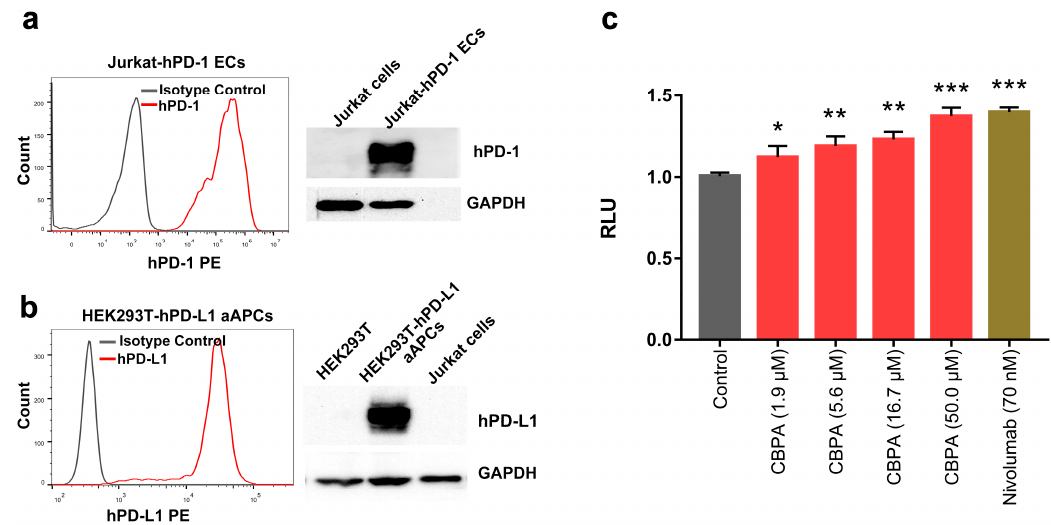
Figure 4. Activity of CBPA in PD-1/PD-L1 checkpoint assay. ( a , b ) Western blot and flow cytometry analysis of the expression of the hPD-1 protein in the Jurkat-hPD-1 effector cells and the expression of the hPD-L1 protein in the HEK293T-hPD-L1 aAPCs, respectively. ( c ) PD-1/PD-L1 checkpoint luciferase reporter assay was used to examine the effects of CBPA in restoring T-cell function. Relative luminescence is normalized to the cells-only groups. Data are displayed as means ± SEM, * p < 0.05, ** p < 0.01, *** p < 0.001, unpaired t -test.